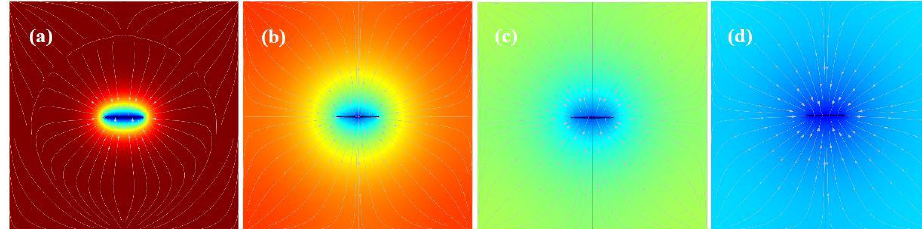
Figure 6. Pressure distribution during the fracturing development derived from the numerical model.